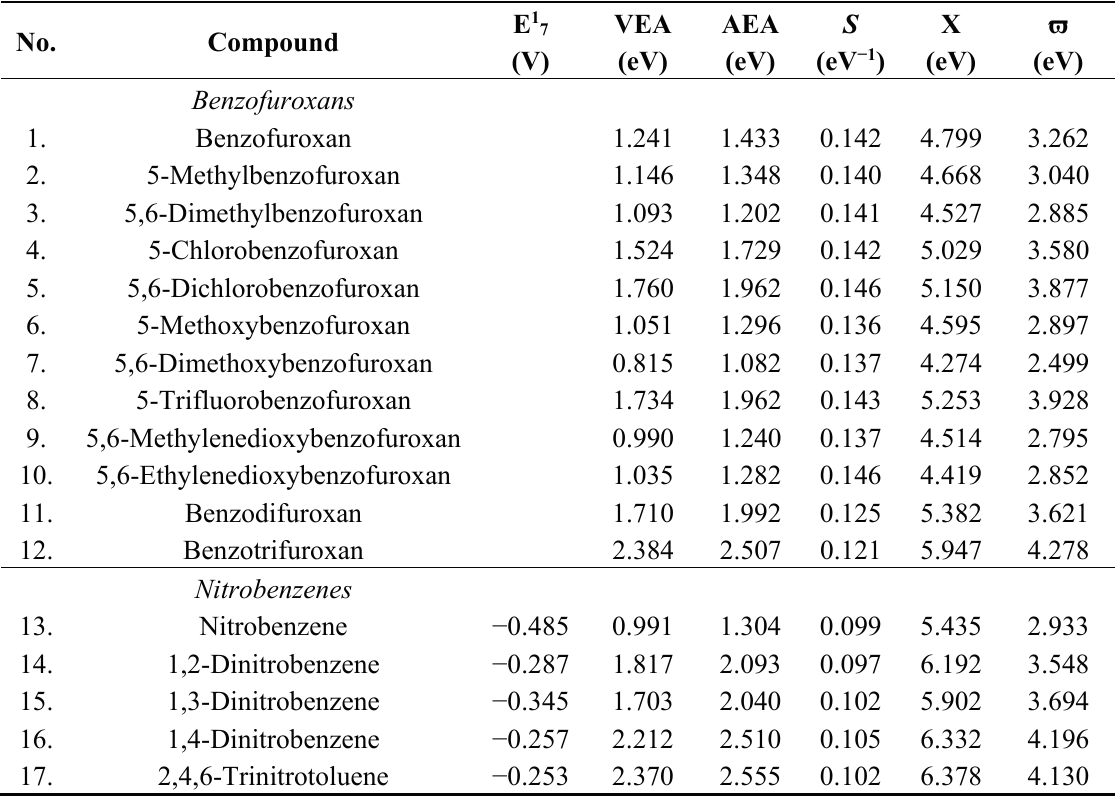
Table 1. The experimental single-electron reduction potentials (E 1 7 ) of nitro-aromatic compounds (NACs) and the quantum mechanical indices of benzofuroxans (BFXs) and NACs as calculated by using the B3LYP/6-311+G(d,p) method: the vertical electron affinity (VEA), the adiabatic electron affinity (VEA), the global softness ( S ), the global electronegativity ( χ ), and the global electrophilicity ( ϖ ). The E 1 7 values are taken from